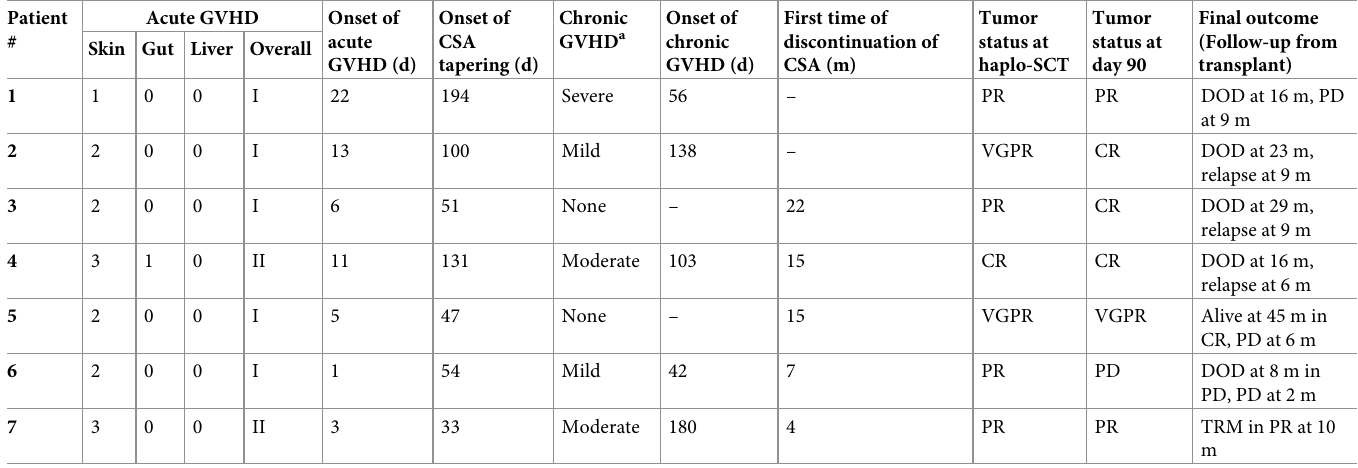
Table 4. GVHD and final